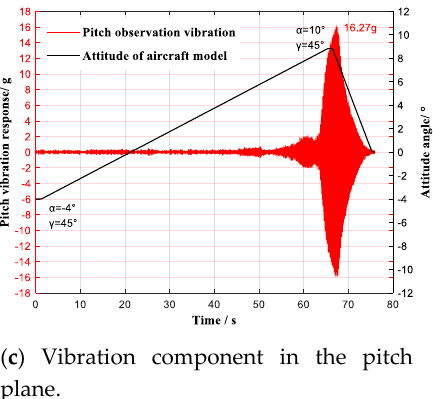
Figure 14. Vibration monitoring with continuous lifting (γ = 0°) of the aircraft model at 0.7 Ma.